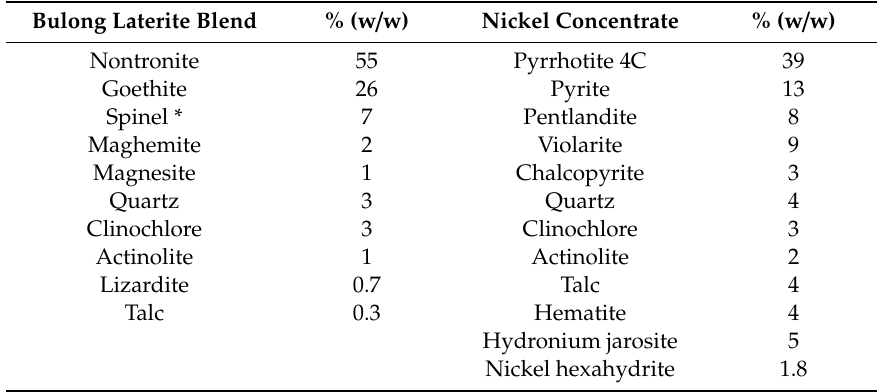
Table 2. Mineral compositions of the blended nickel laterite ore and (hydrothermally heated) fresh nickel concentrate feeds employed for the current test work. Bulong Laterite Blend % (w / w) Nickel Concentrate % (w / w) Nontronite 55 Pyrrhotite 4C 39 Goethite 26 Pyrite 13 Spinel * 7 Pentlandite 8 Maghemite 2 Violarite Magnesite 1 Chalcopyrite